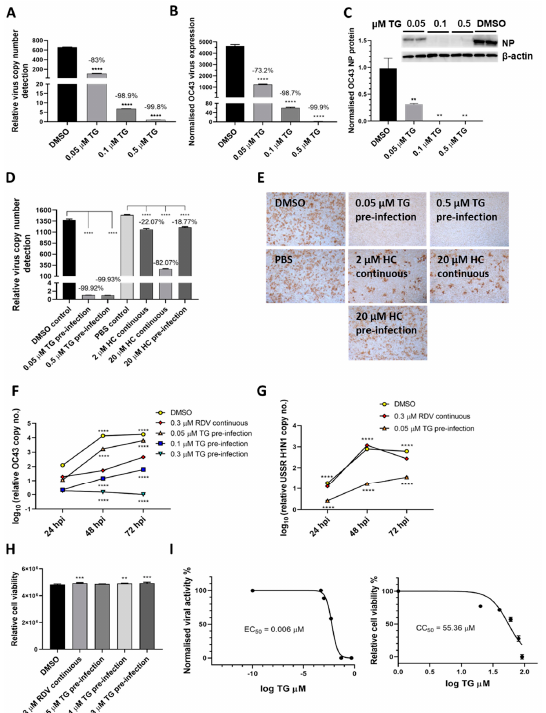
Figure 4. TG inhibits OC43 viral transcription and protein production, is more effective as an antiviral than hydroxychloroquine and remdesivir, and exhibits a high selectivity index. ( A , B ) A549 cells were primed with TG for 30 min, washed twice with PBS and infected with OC43 at 0.5 MOI for 3 h; cells were then washed again with PBS and cultured for 48 h in serum-free media (Opti-MEM supplemented with 0.1 µg/mL TPCK trypsin), after which RNA was extracted from (A) culture media and ( B ) cells for one-step reverse transcription qPCR, and cDNA conversion followed by qPCR, respectively, to detect viral OC43 replicase polyprotein 1ab RNA; cDNA quantification was normalised to 18s rRNA. ( C ) Duplicate set of wells were used for cellular protein extractions to detect OC43 NP by Western blotting. ( D , E ) MRC5 cells were primed with TG, hydroxychloroquine (HC) or the DMSO/PBS control, as indicated, for 30 min, washed twice with PBS, infected with OC43 (at 0.01 MOI) for 3 h, further washed with PBS twice and finally replenished with serum-free media in the absence of a compound (pre-infection) or continued presence of HC (continuous). At 2 dpi, media were collected for ( D ) detection of viral polyprotein 1ab RNA by one-step reverse transcription-qPCR and ( E ) direct progeny virus detection by infecting A549 cells for 24 h and immunostaining for the presence viral NP. Images captured at 100 times magnification. The indicated significance (determined by one-way ANOVA) and percentage reduction in viral RNA detection are relative to the corresponding controls. ( F , G ) TG was superior to remdesivir (RDV) in blocking OC43 ( F ) and influenza A virus ( G ) replication. The A549 cells were primed with the indicated TG, 0.3 µM RDV or DMSO control for 30 min, washed twice with PBS and infected with 0.01 MOI of CoV OC43 or 1.0 MOI of USSR H1N1 virus for 2 h, after which cells were washed again with PBS and incubated in serum-free media for TG primed cells, or in media in the continuous presence of RDV. At 24, 48 and 72 hpi, viral RNA extraction was performed on the collected supernatants followed by one-step reverse transcription qPCR to detect the relative copy number of OC43 replicase polyprotein 1ab RNA or influenza M-gene RNA, based on the relative Ct method. The indicated significance is relative to the corresponding RDV-treated cells based on 2-way ANOVA Dunnett’s ( F ) or Tukey’s ( G ) multiple comparisons test. ( H ) RDV and TG treatments had no adverse effect on cell viability. A549 cells were treated continuously with RDV, or for 30 min with the indicated TG or DMSO, washed, cultured overnight and subjected to cell viability assay (CellTiter-Glo 2.0 Cell Viability Assay, Promega). The indicated significance was determined by one-way ANOVA relative to the DMSO control. ( I ) Selectivity index (CC 50 /EC 50 ) of TG in OC43 inhibition was estimated at between 7072 and 9227. EC 90 = 0.02622 µ M. MRC5 cells were primed with TG (0 to 91 µ M) for 30 min, washed twice with PBS and culture in DMEM Glutamax with 10% FCS and 1% P/S overnight. Cell viability assay (CC 50 ) was performed with CellTiter-Glo 2.0 Cell Viability Assay (Promega). The effective or inhibition TG dose response (EC 50 ) was based on priming of MRC5 cells with the indicated concentrations of TG (0 to 0.5 µ M) for 30 min followed by PBS washing and infection with OC43 at 0.01 MOI. Three days post-infection, the supernatants were harvested for RNA extraction and one-step reverse-transcription qPCR to quantify the presence of viral RNA (polyprotein 1ab RNA). CC = cell cytotoxicity; EC = effective concentration. ** p < 0.01, *** p < 0.001 and **** p <